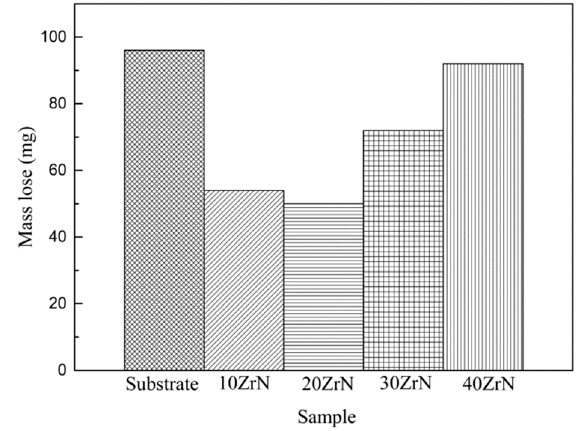
Figure 9. Mass loss of di ff erent coatings after pin-on-disc dry sliding wear test.